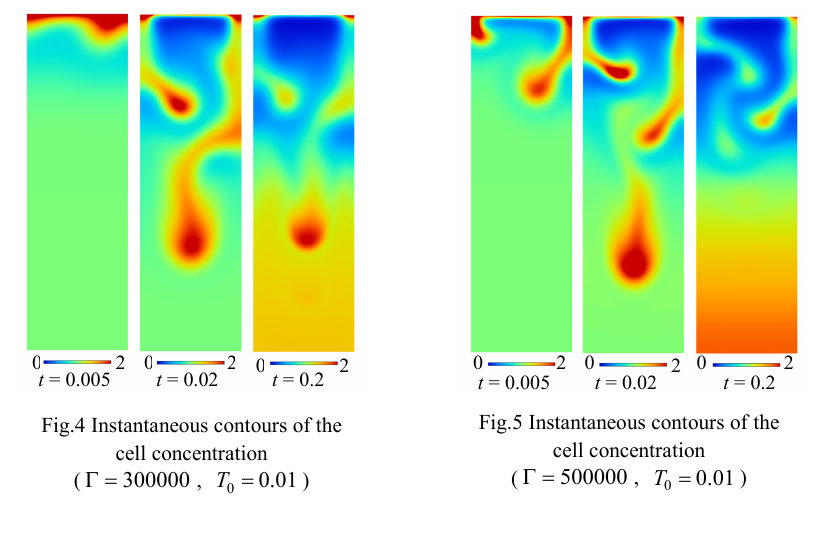
Fig.2 Instantaneous contours of the Fig.3 Instantaneous contours of the